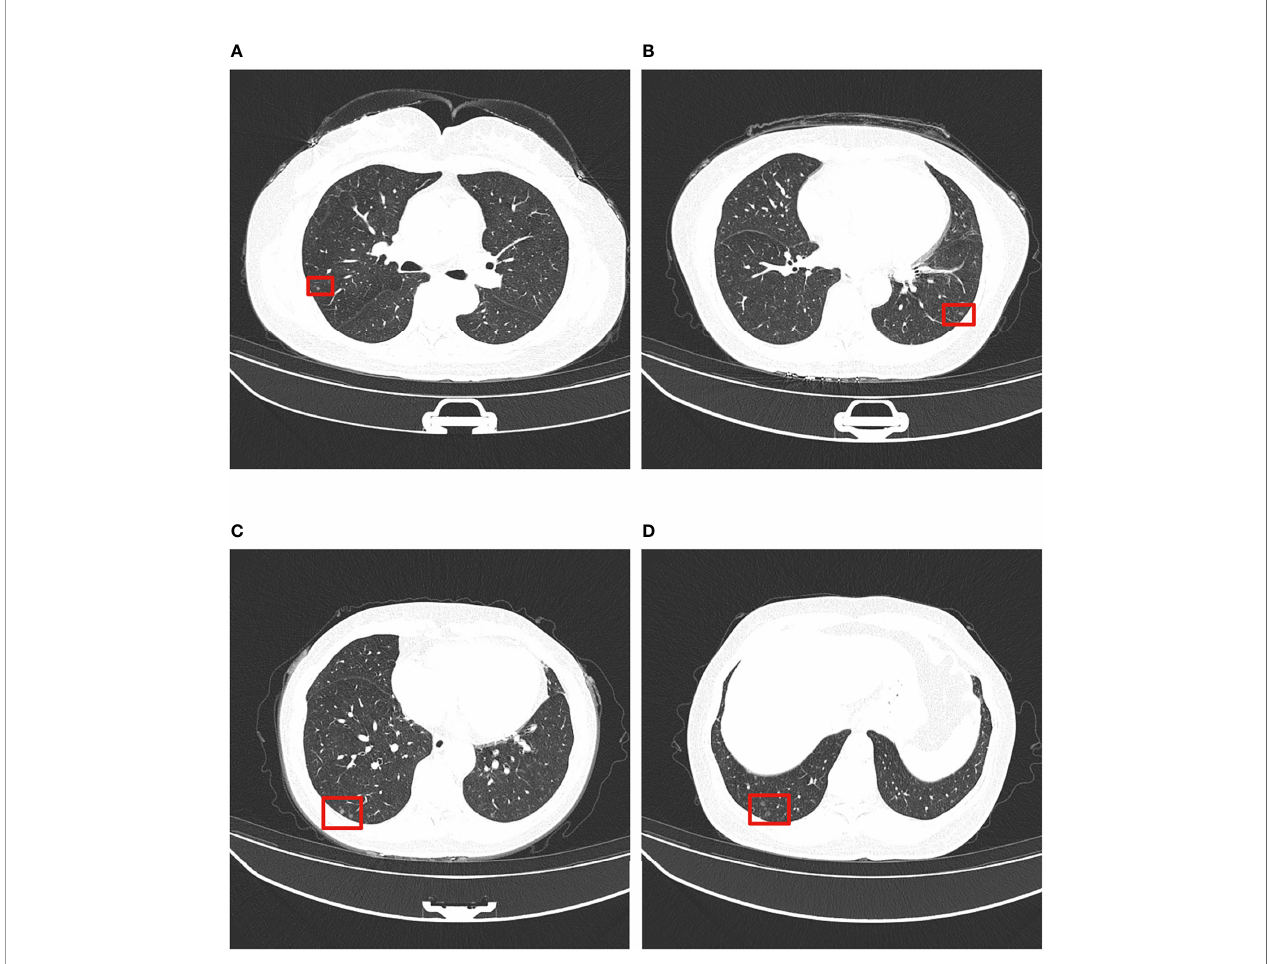
FIGURE 1 | Typical thin-section CT presentation of MPMNs. Multiple ground glass density shadows in the middle and lower lobes of the left and right lungs (shown in red boxes), 0.2-0.4 cm in diameter, with irregular shadows and slightly blurred boundary. (A – D) show ground glass density nodules in left and right lungs at different CT